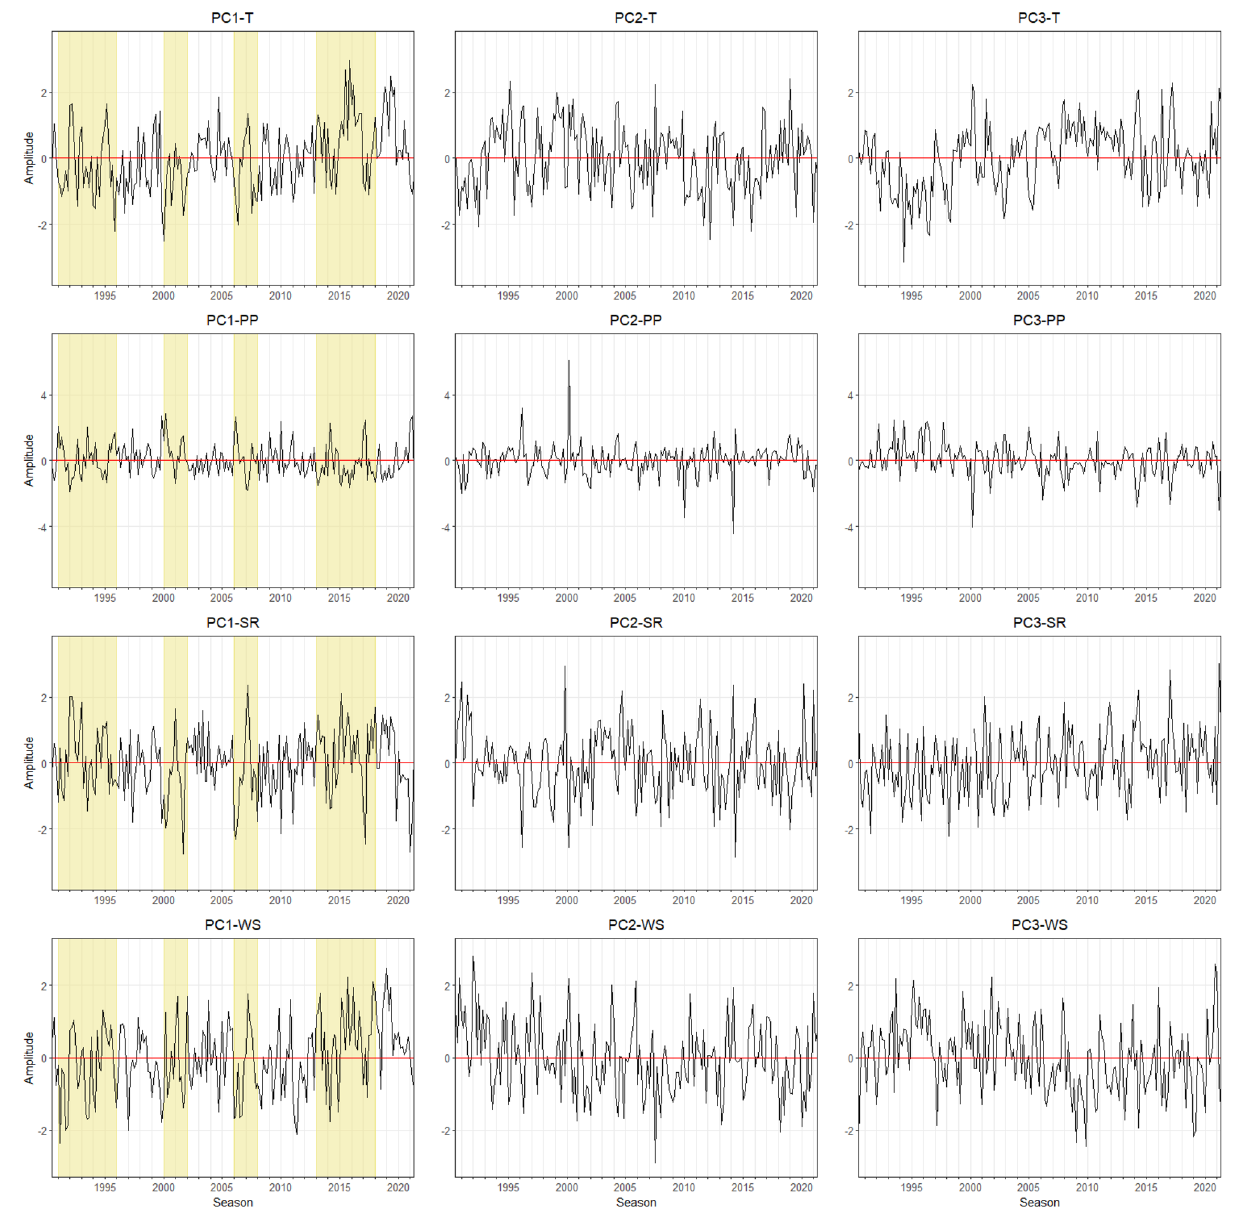
Figure 9. Monthly time series of growing season patterns (principal components, PC) corresponding to EOF- 1, EOF-2, and EOF-3 for the North West province (see Fig. 8). Strong positive or negative anomalies of the dominant mode are highlighted (extreme events). The x-axis ticks indicate the beginning period of growing season. The abbreviations of agrometeorological data (T, PP, SR, WS) refer to Table